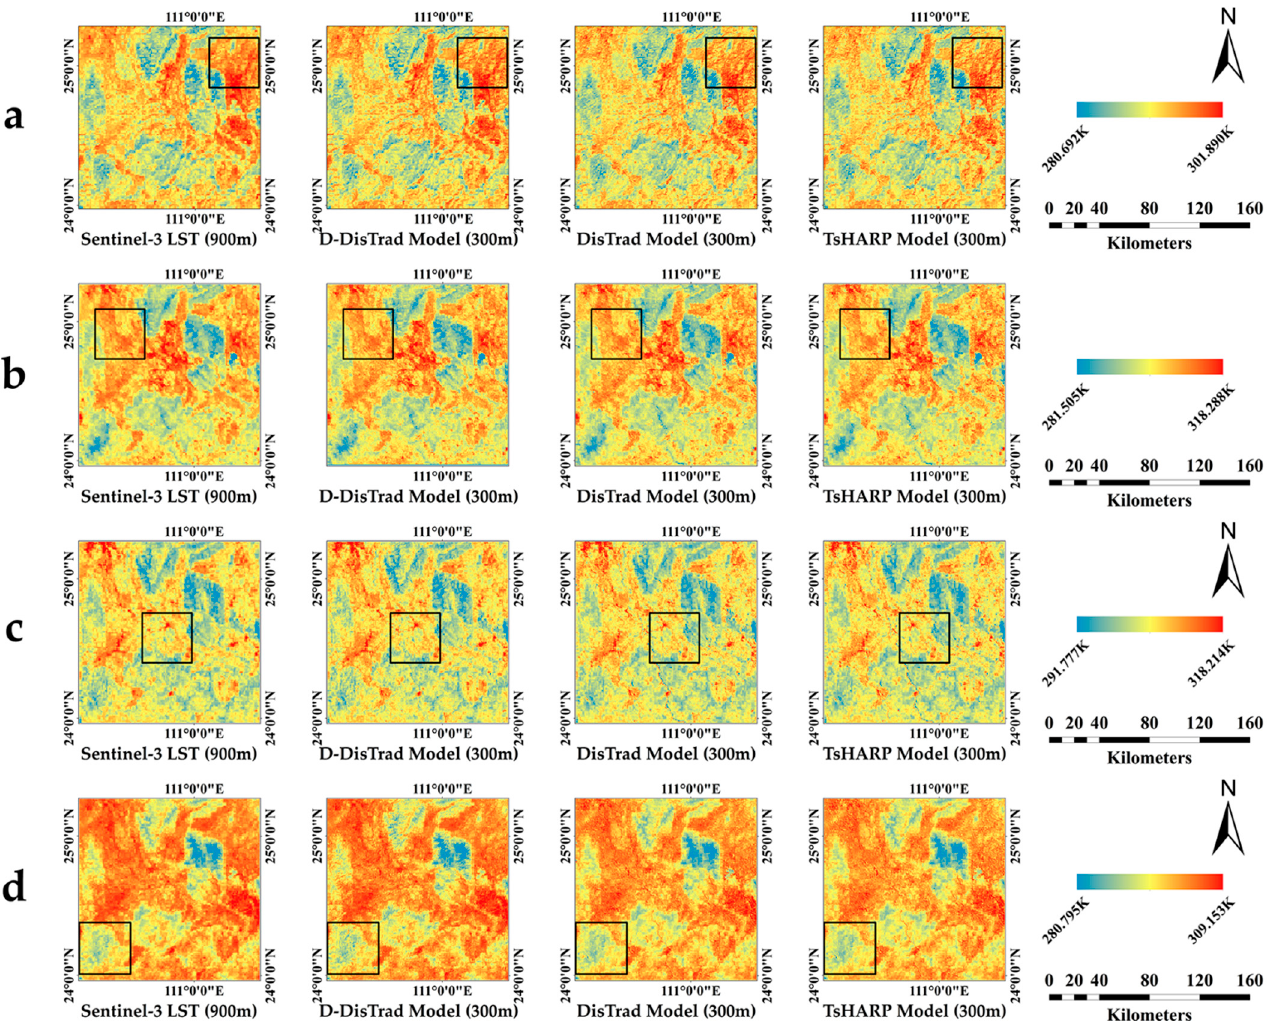
Figure 7. Each line goes from left to right, showing SLSTR LST (900 m), D-DisTrad LST (300 m), DisTrad LST (300 m), and TsHARP LST (300 m) data in site 2 across 4 seasons: ( a ) winter; ( b ) spring; ( c ) summer; ( d ) fall.